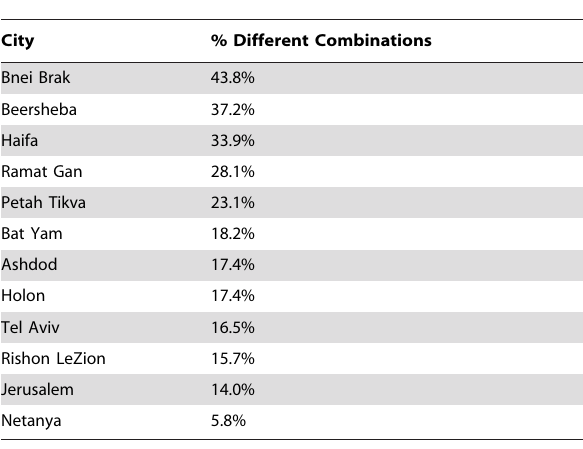
Table 3. Fraction of combinations (two cities and a season) in which incidence curves were found to be significantly different, out of each city’s 121